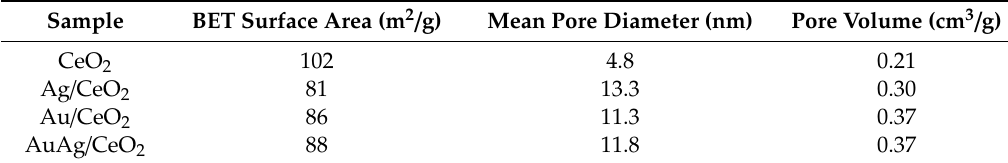
Table 1. Textural features of the examined catalysts.